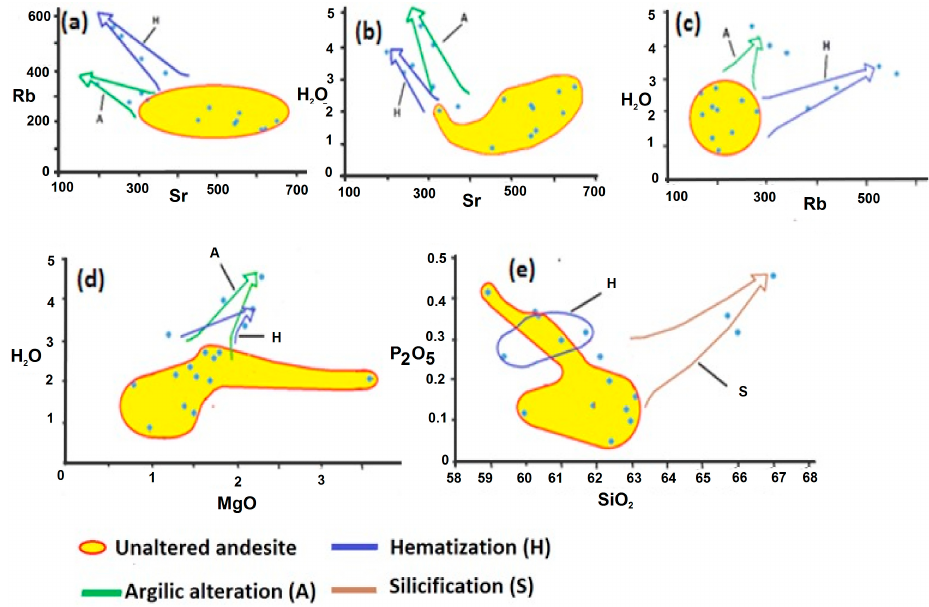
Figure 8. Binary plots of ( a ) Rb vs. Sr; ( b ) H 2 O vs. Sr; ( c ) H 2 O vs. Rb; ( d ) H 2 O vs. MgO; and ( e ) P 2 O 5 vs. SiO 2 for the unaltered and altered andesite.